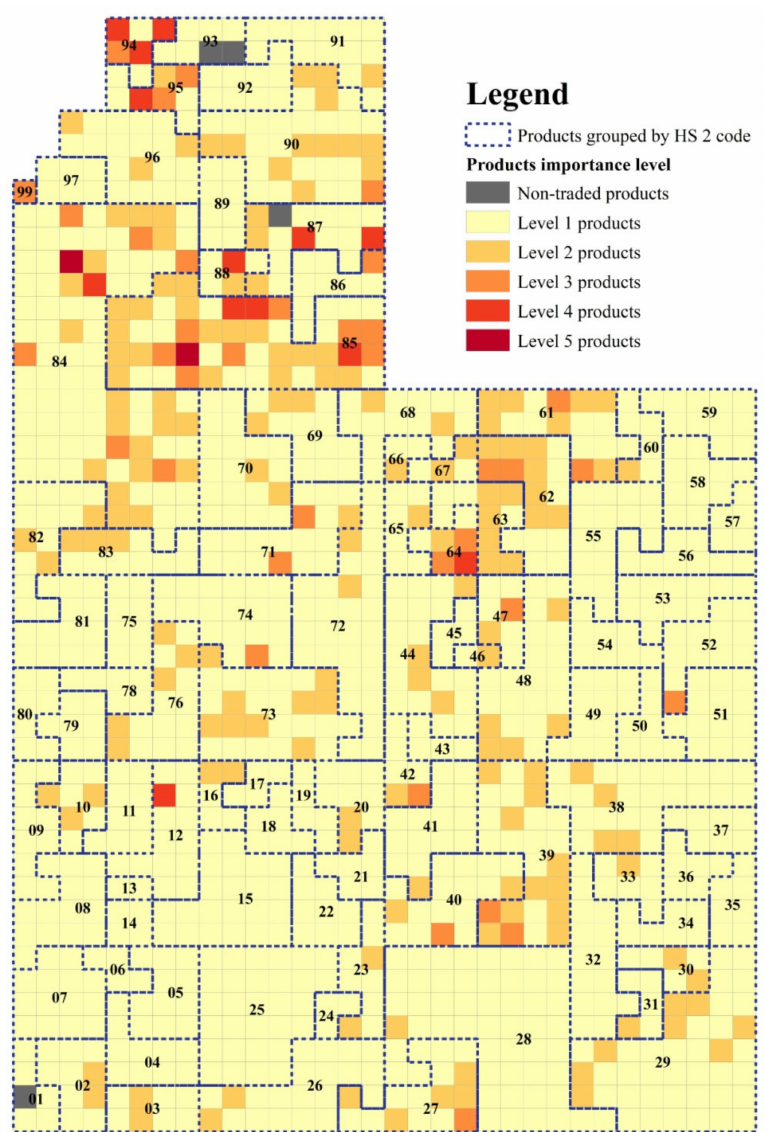
Figure 5. Spatial pattern of product importance level in China–US bilateral